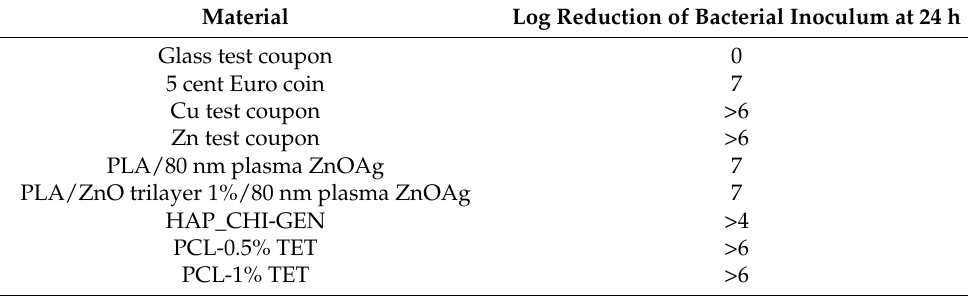
Table 1. Antibacterial activity of the tested surfaces with S. aureus . Material Log Reduction of Bacterial Inoculum at 24 h Glass test